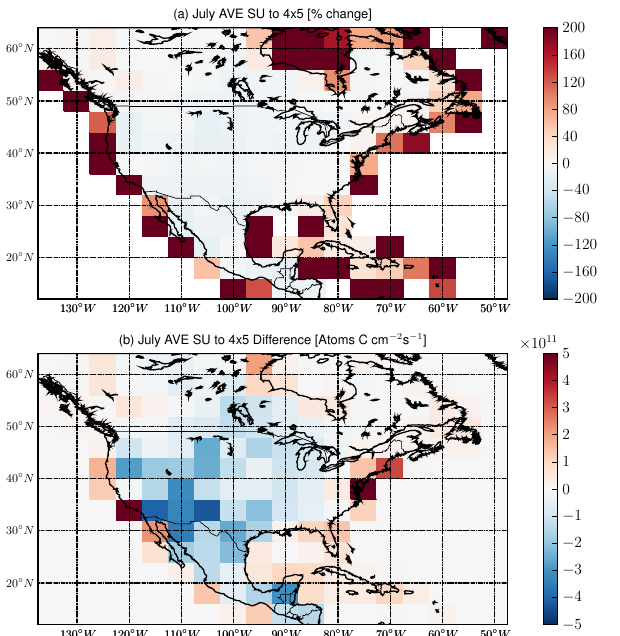
Fig. 9. Monoterpene emissions comparisons between the scaled up 0.5 ◦ × 0.667 ◦ simulations (SU) and the 4 ◦ × 5 ◦ simulations aver- aged over July. Panel (a) is the % difference between the SU and 4 ◦ × 5 ◦ monoterpene emissions and (b) is the absolute difference (atoms C cm − 2 s − 1 )